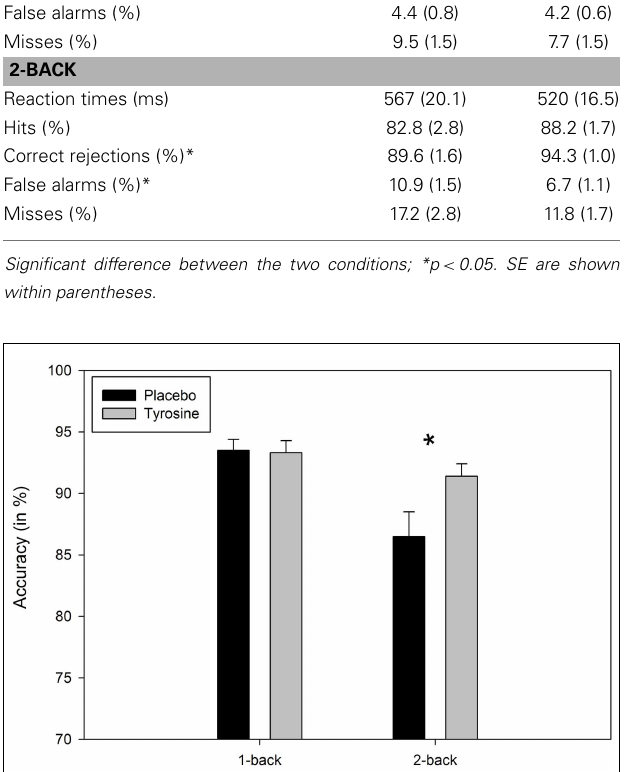
94.3%,afterplaceboandTYR,respectively), t (21) = 2.47, p = 0.02, and participants’ accuracy (86.5 vs. 91.4% after placebo and TYR, respectively), t (21) = 2.54, p = 0.02, see Figure 1 , [ d (cid:48) ( placebo ) = 2.4, d (cid:48) ( TYR ) = 2.9 ]